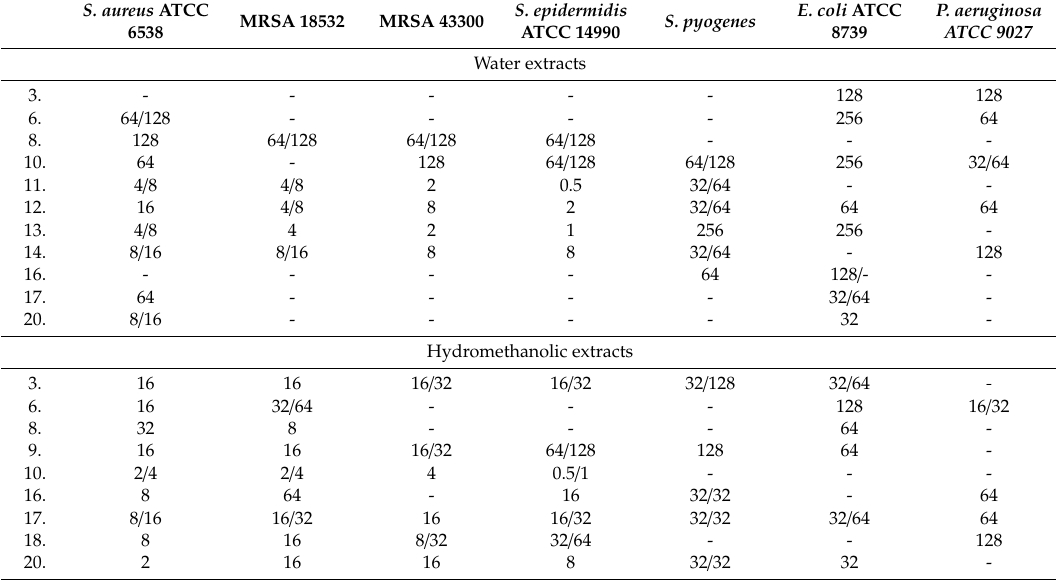
Table 3. Antimicrobial activity of water and hydromethanolic extracts of R. canina L. against tested bacterial